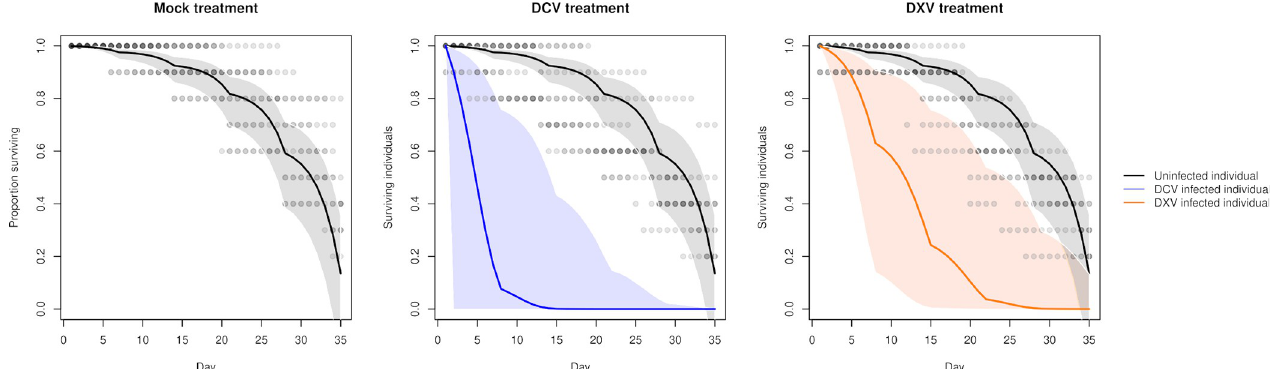
Fig 3. Points indicate the proportion of surviving individuals in each vial. Transparency is used to indicate overlapping values. Colored lines are the mean estimated survival probabilities that is composed entirely of uninfected flies (panel A), infected with DCV (panel B), or infected with DXV (panel C). Shaded regions denote the 95% credible interval of the